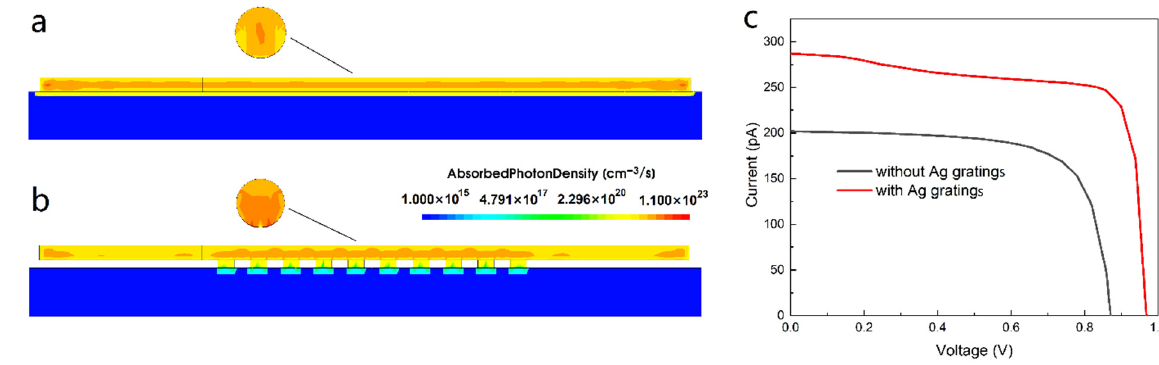
Figure 3. ( a , b ) The cross-sectional and longitudinal optical generation profiles of the laterally oriented NW without Ag gratings and with Ag gratings, respectively; ( c ) the current–voltage characteristics of the laterally oriented NW without (black) and with (red) Ag gratings.